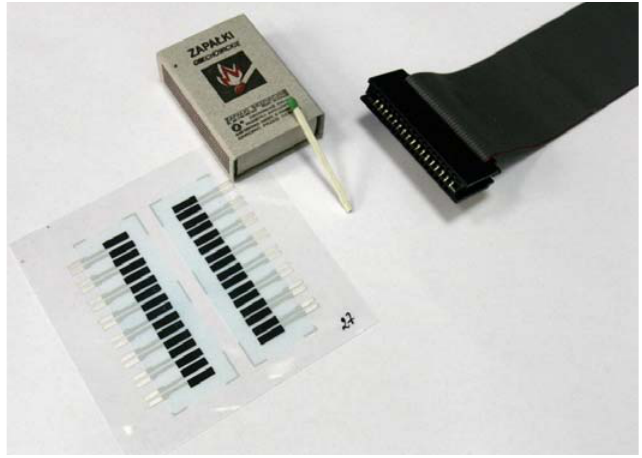
Figure 4. Photo of screen-printed sensors and connector compatible to